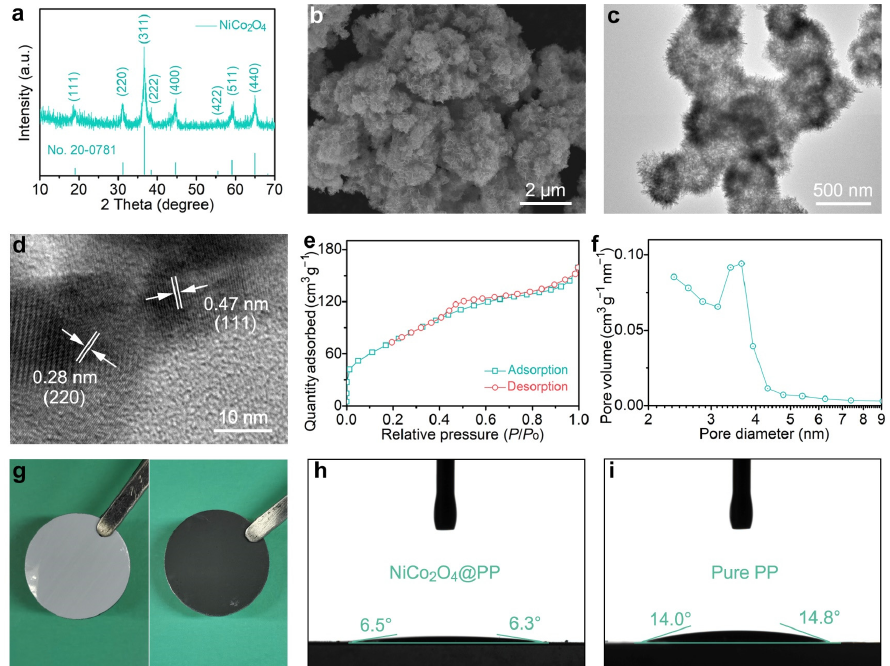
Figure 2. ( a ) XRD, ( b ) SEM, ( c ) TEM, and ( d ) HRTEM characteristics of the as-obtained NiCo 2 O 4 sample. ( e , f ) N 2 adsorption–desorption isotherm and pore size distribution. ( g ) Photographs of the NiCo 2 O 4 @PP separator. ( h , i ) Contact angle tests of the modified and pure separators.